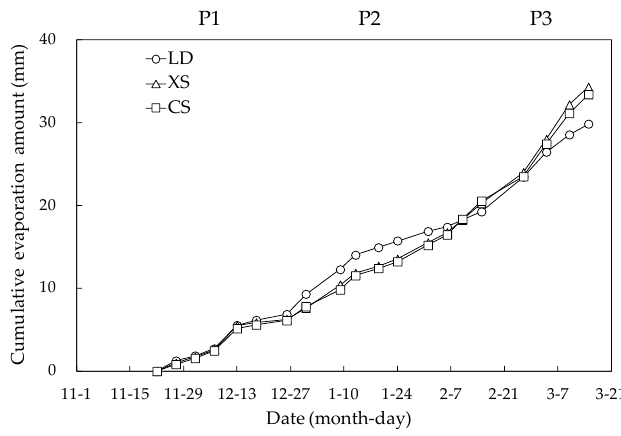
Figure 3. Cumulative evaporation amount under different sand mulches during the freeze – thaw period.